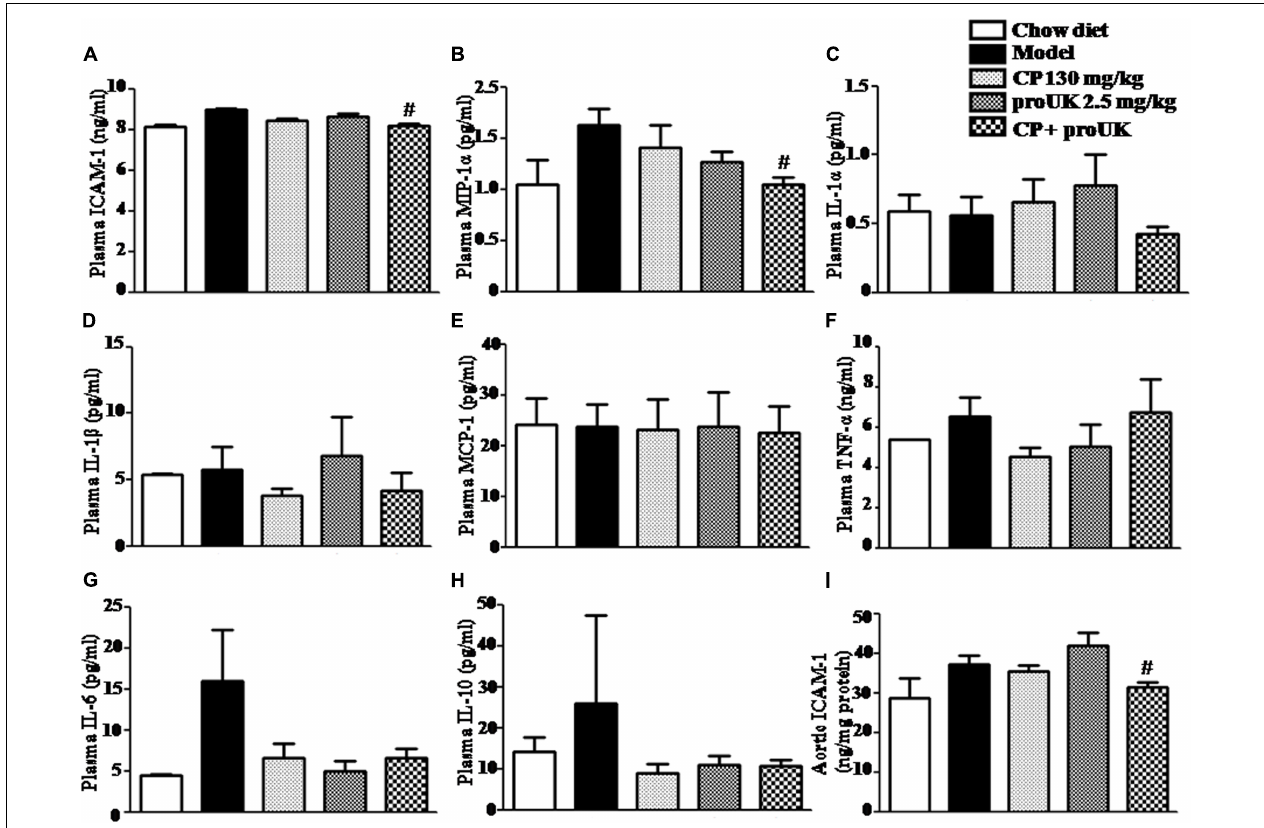
FIGURE 8 | Effect of CP plus proUK on plasma inflammatory cytokine levels in LDLR − / − mice. (A) Plasma ICAM-1 detected by ELISA in LDLR − / − mice from different groups. (B) Plasma MIP-1 α in LDLR − / − mice from various groups. (C) Plasma IL- α in LDLR − / − mice from various groups. (D) Plasma IL-1 β in LDLR − / − mice from various groups. (E) Plasma MCP-1 in LDLR − / − mice from various groups. (F) Plasma TNF- α in LDLR − / − mice from various groups. (G) Plasma IL-6 in LDLR − / − mice from various groups. (H) Plasma IL-10 in LDLR − / − mice from various groups. (B–H) All the data were acquired by Flow cytometer. (I) The concentrations of aortic ICAM-1 protein measured by ELISA in LDLR − / − mice from various groups. The values are presented as the means ± SEM, n = 8–12. # P < 0.05 vs. Model